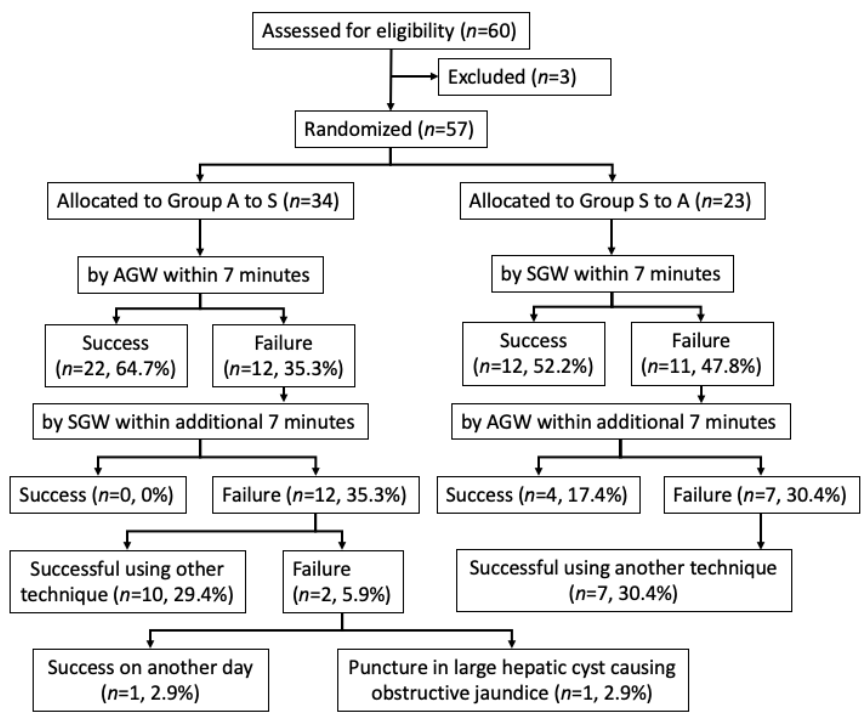
Figure 1. Consort chart of patient enrollment and randomization. AGW, angled-tip guidewire; SGW, straight-tip guidewire. Table 2. Successful selective biliary cannulation rate and time for cannulation for 14 min.